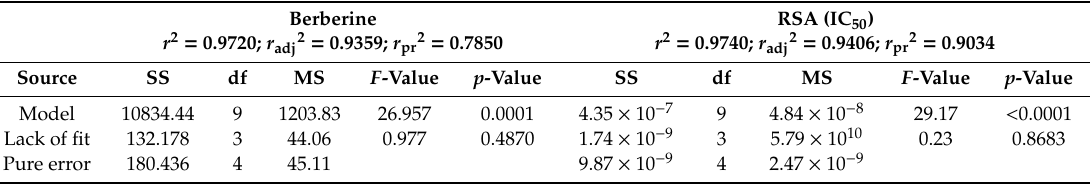
Table 4. Analysis of variance (ANOVA) for the fitted quadratic polynomial model for optimization of extraction parameters.